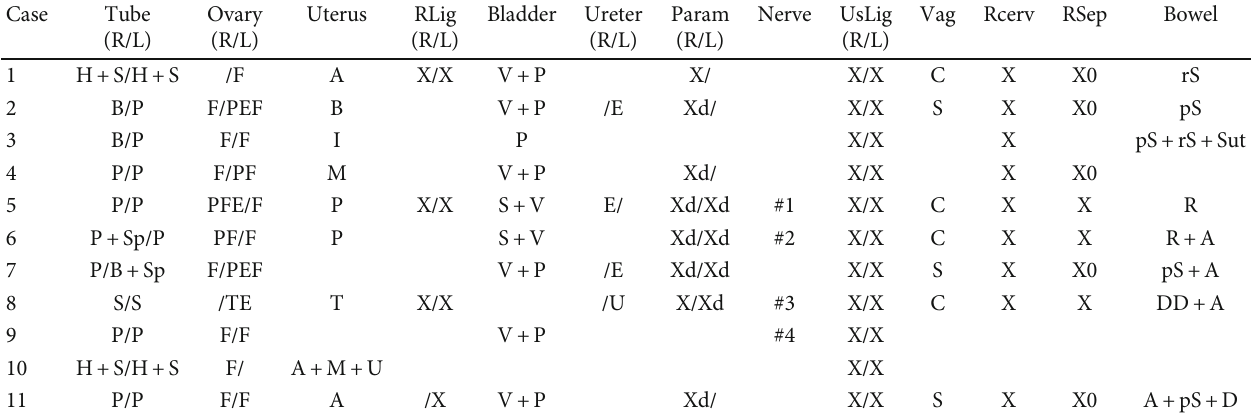
Table 3: Systematic description of surgical procedures performed at the main sites a ff ected by endometriosis.